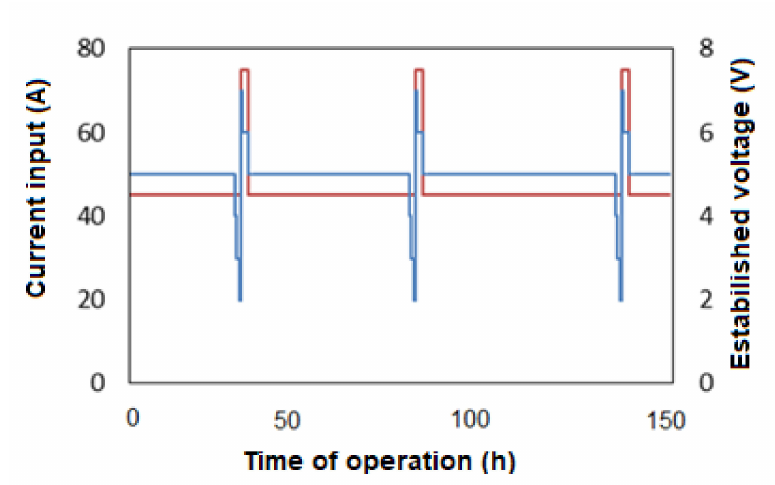
Figure 3. The example of current (red, main y-axis) and voltage (blue, secondary y-axis) control during